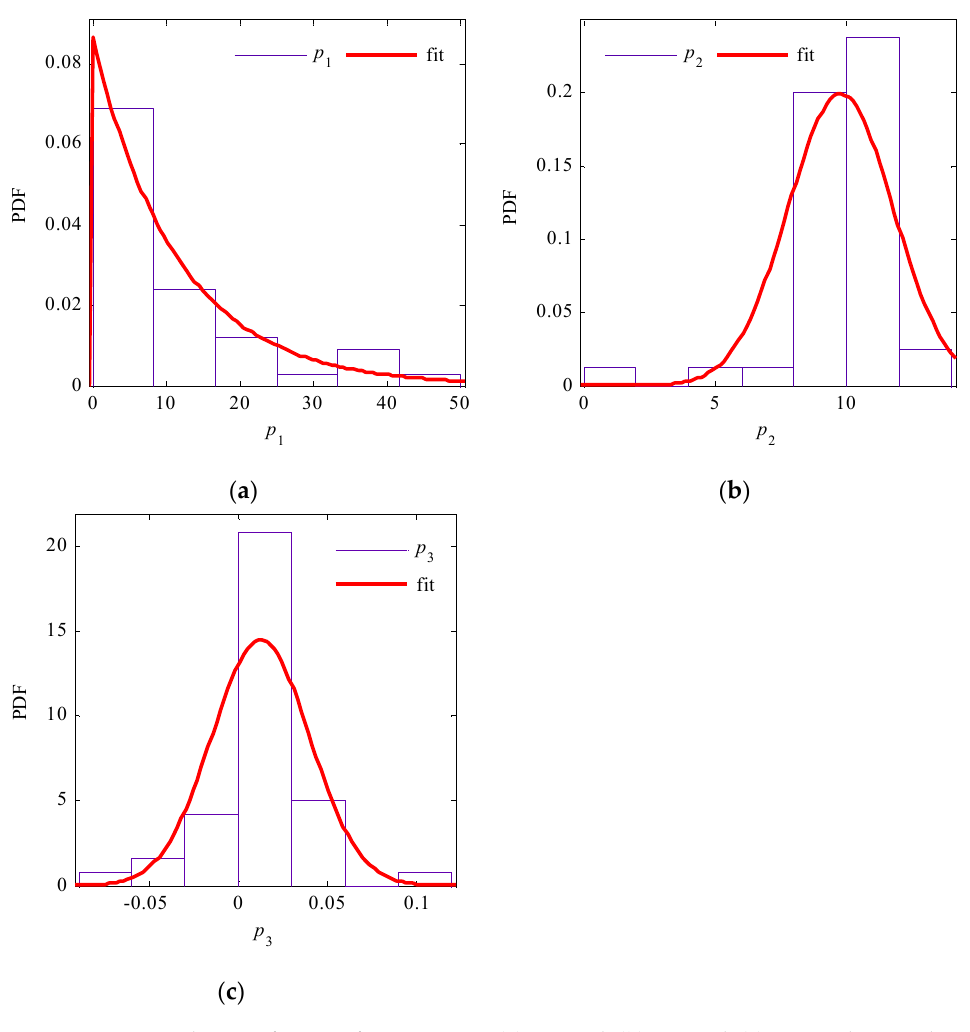
Figure 17. Distribution fitting of parameters ( a ) p 1 and ( b ) p 2 and ( c ) p 3 in the amplitude transfer function. Table 1. Probability distribution of parameters in the amplitude and phase transfer functions.